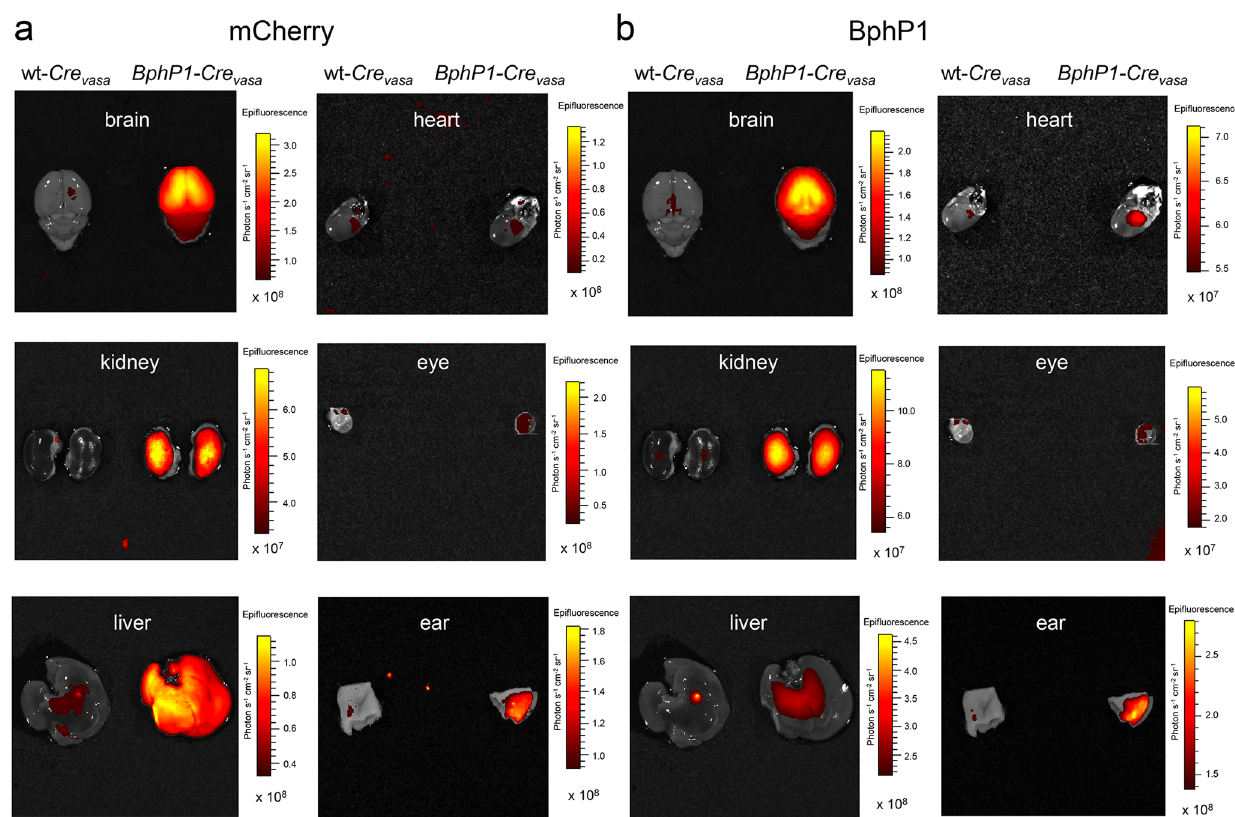
Fig. 2 Imaging of wt- Cre vasa and BphP1-Cre vasa mouse organs. Mice were euthanized and freshly isolated individual organs were sequentially visualized. Signals were acquired using IVIS Spectrum for ( a ) mCherry fl uorescence (Ex. 570/20 nm, Em. 620/30 nm) and ( b ) BphP1 fl uorescence (Ex. 675/20nm, Em. 720/30 nm). Fluorescence images of organs isolated from wt- Cre vasa (left column) and hemizygous BphP1-Cre vasa (right columns) mice are shown. For more details, see “ Statistics and reproducibility ” section of the